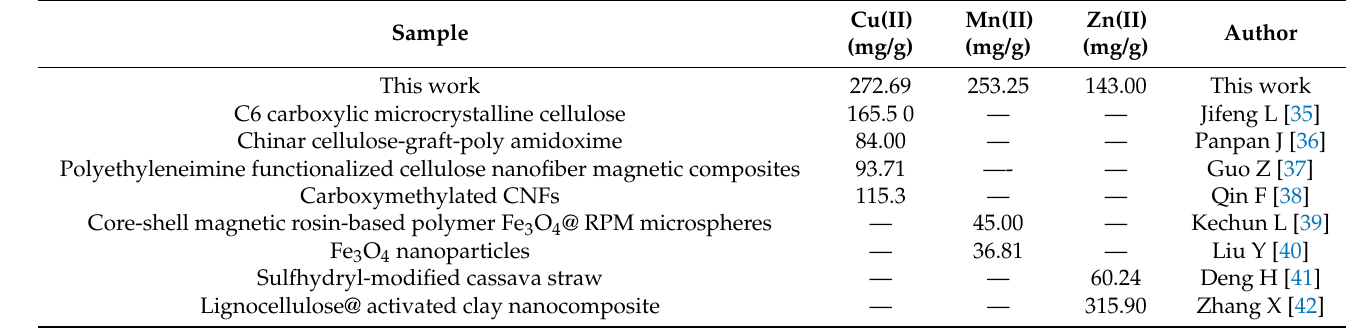
Table 3. Comparison of adsorption properties of different materials for Cu 2+ , Mn 2+ , and Zn 2+ . Sample